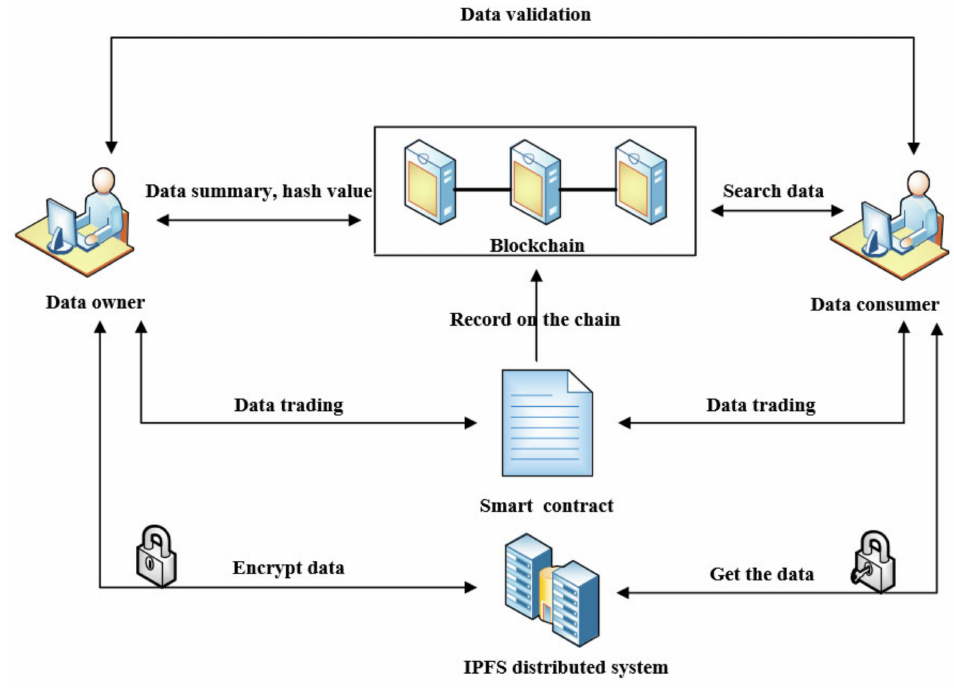
Figure 3. Data transaction